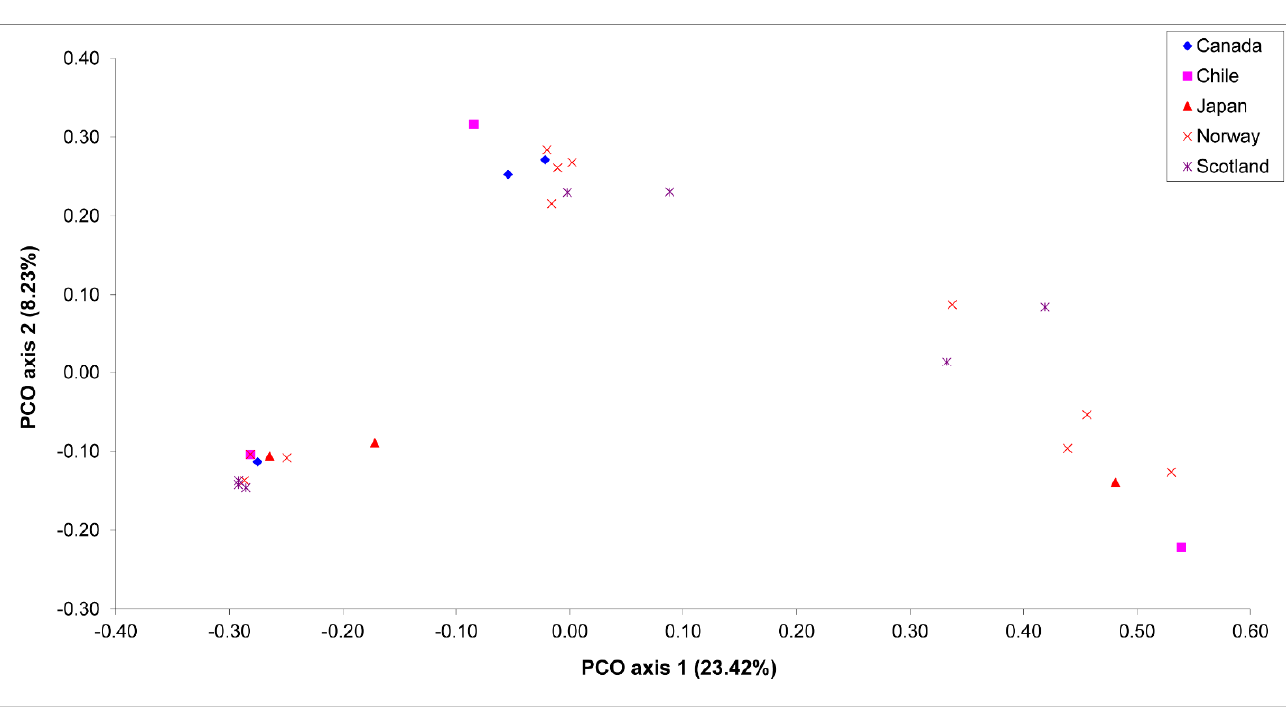
Figure 2. Score plot of principal coordinate analysis (PCO) of isolates of Saprolegnia spp. as revealed by using 163 polymorphic AFLP bands, collected from Canada, Chile, Japan, Norway and Scotland.